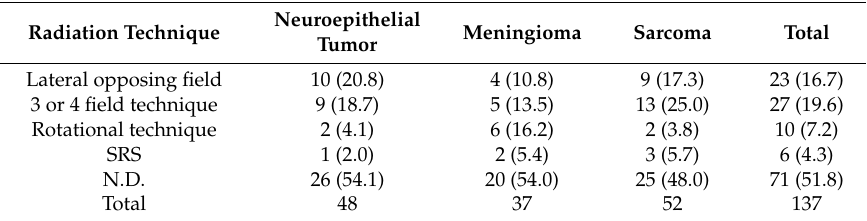
Table 2. Radiation technique and secondary brain tumor, n (%).